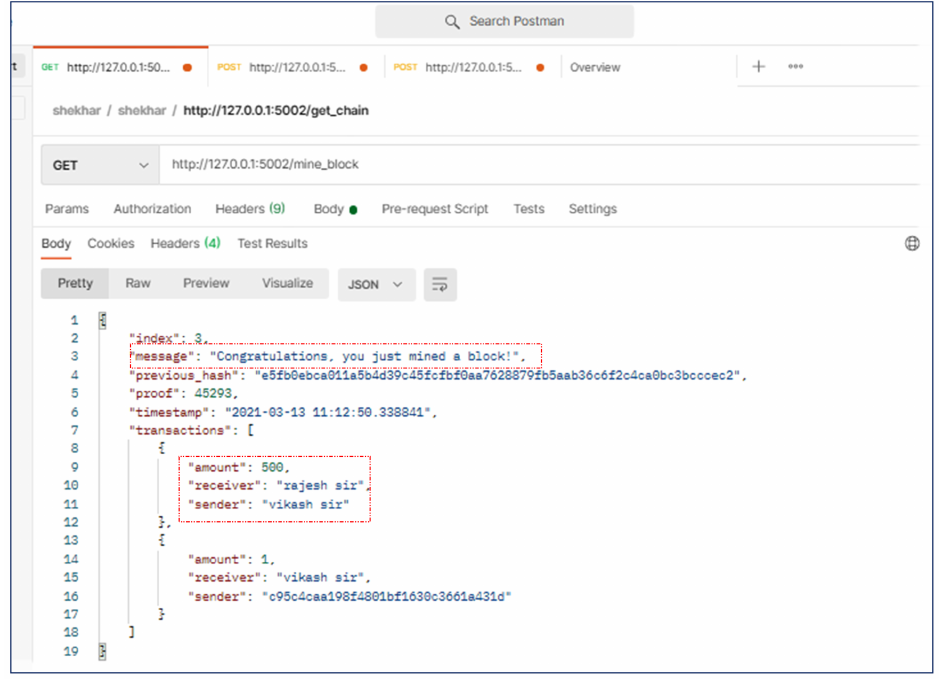
Figure A9. Transaction added after mining.